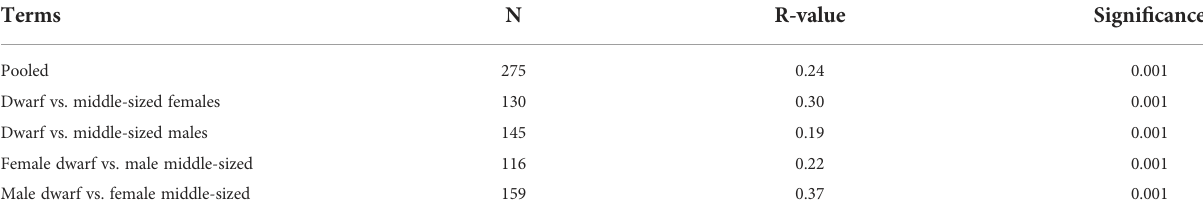
TABLE 2 Results of analysis of similarities (ANOSIM) for gladius morphometric characteristics of the dwarf without a dorsal photophore and middle-sized typical forms Sthenoteuthis oualaniensis in the South China Sea.